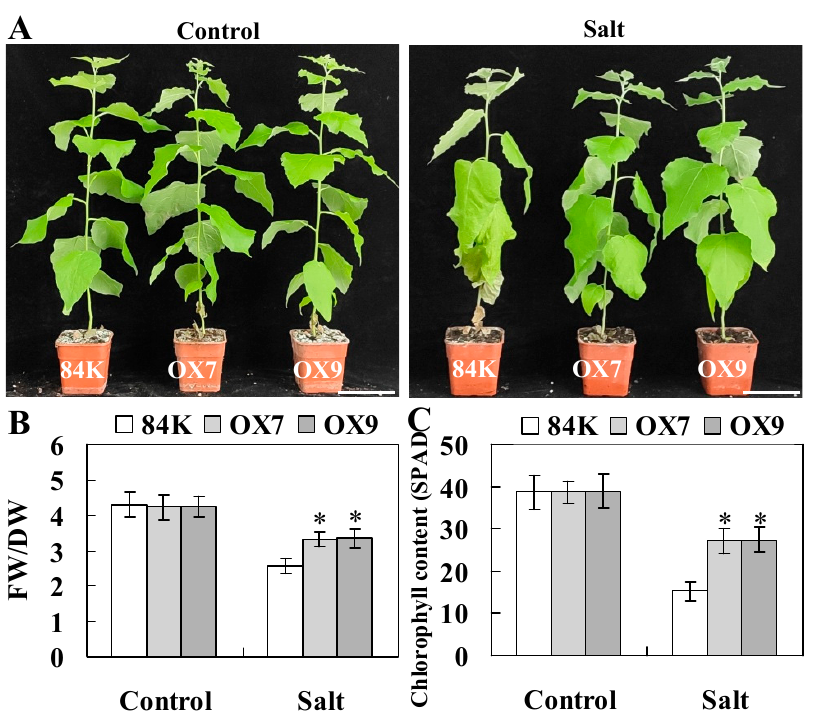
Figure 4. ThHSFA1 enhances salt tolerance in transgenic poplar. The phenotype ( A ), fresh weight/dry weight (FW/DW) ratio ( B ), and chlorophyll content ( C ) of nontransgenic 84K and transgenic (OX) plants. Four-week-old nontransgenic 84K and transgenic plants cultivated in vitro were grown in soil for 30 days and subsequently irrigated with 0 (control) or 200 mM NaCl (salt) every 2 days for 10 days. The error bars represent ± SD from multiple biological replicates, and the asterisks indicate significant differences between nontransgenic 84K and transgenic plants (*, p < 0.05). Scale bars = 10 cm.